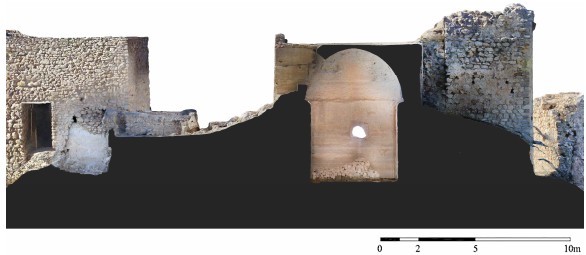
Figure 10. Section of the two cisterns of the fortress of